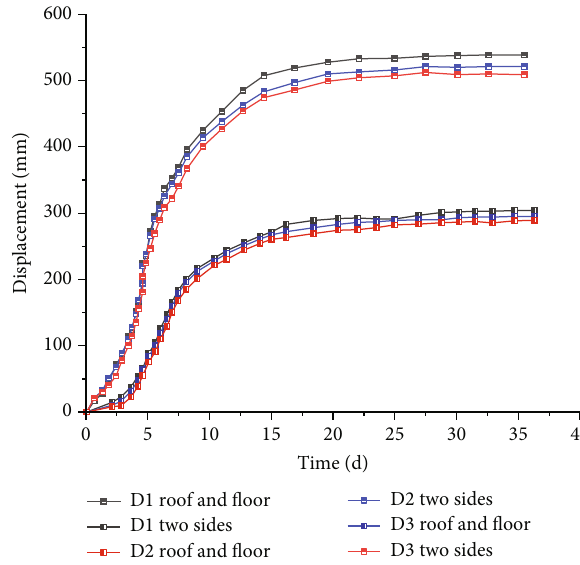
Figure 10: Deformation of surrounding rock in 4302